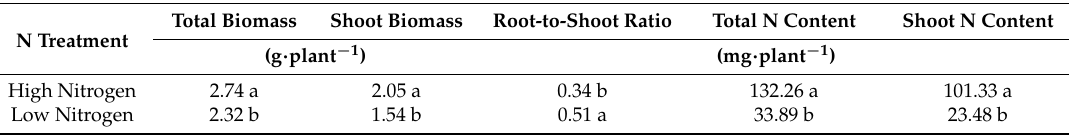
Table 1. Effect of nitrogen supply on biomass and nitrogen accumulation in maize plants at the V6 stage.